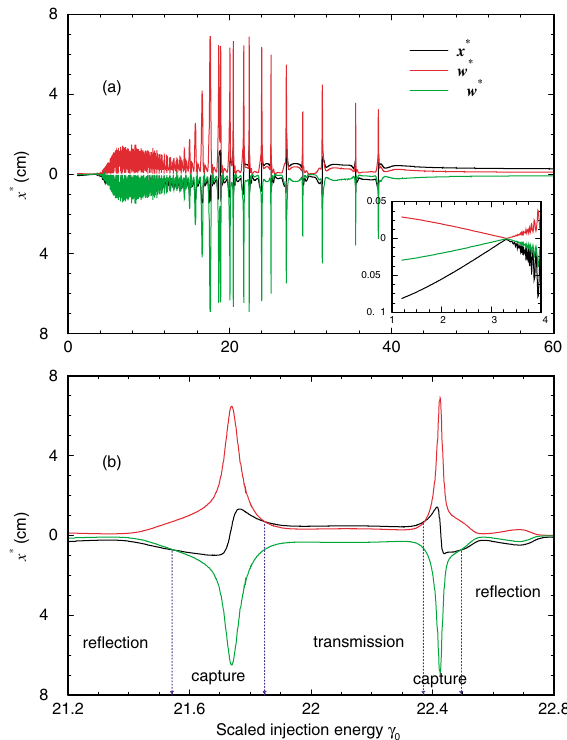
FIG. 11. (Color) Transverse electron coordinate x (cid:20) (black curve), at the end of the interaction time, vs the scaled injection energy. Shown in red and green, as a background to help in classifying the events, are the corresponding values of (cid:14) w (cid:20) , where w (cid:20) is the radius of the beam cross section at the end of the interaction time corresponding to !t (cid:3) 3 : 101 35 (cid:9) 10 6 . The range of injection energies in (b) is centered on (cid:15) shown in Fig. 6. All parameters are the same as in Fig. 6 and the legends in (a) apply to (b) as